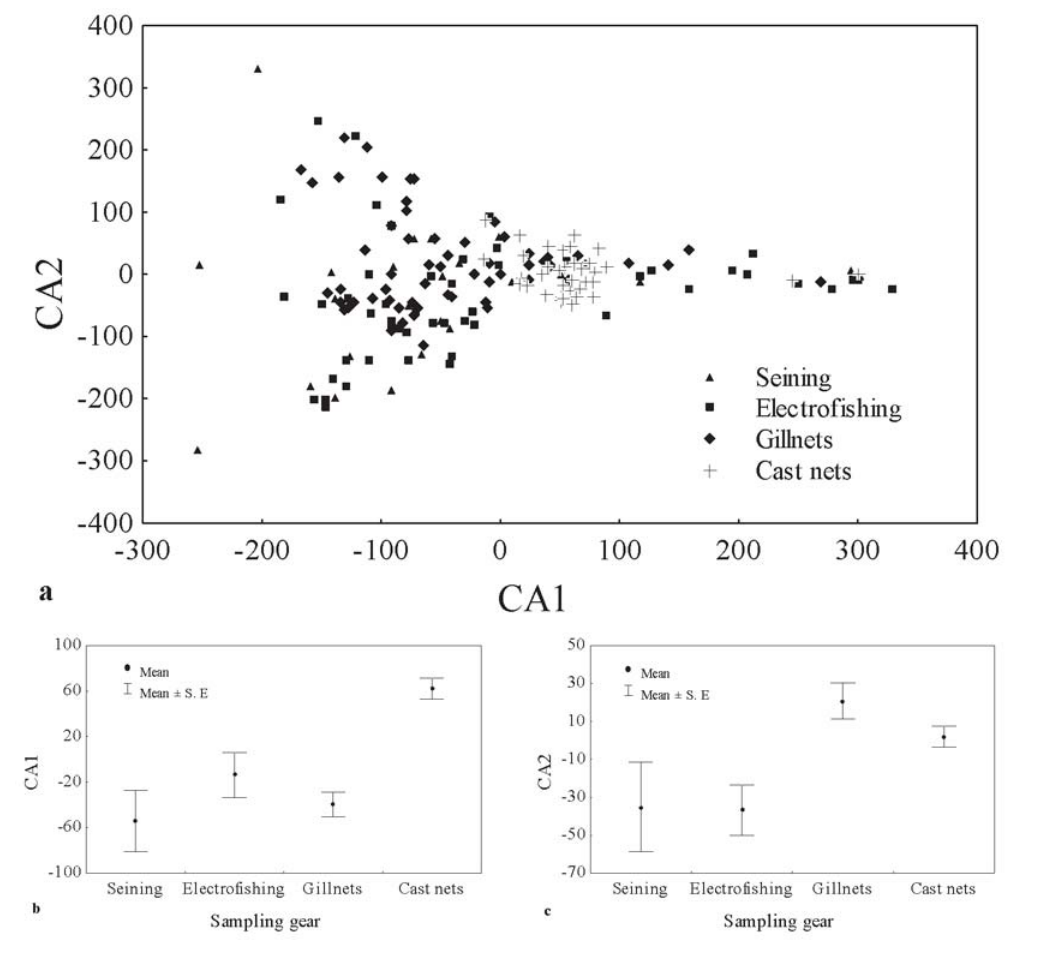
Fig. 3. Ordination (correspondence analysis – CA; Axis 1 – CA1; Axis 2 – CA2) of the samples taken with seining nets, electrofishing, gillnets, and cast nets, at different stations located in the Canal da Piracema (a). Representation of the mean scores by fishing gears in axis 1 (b) and axis 2